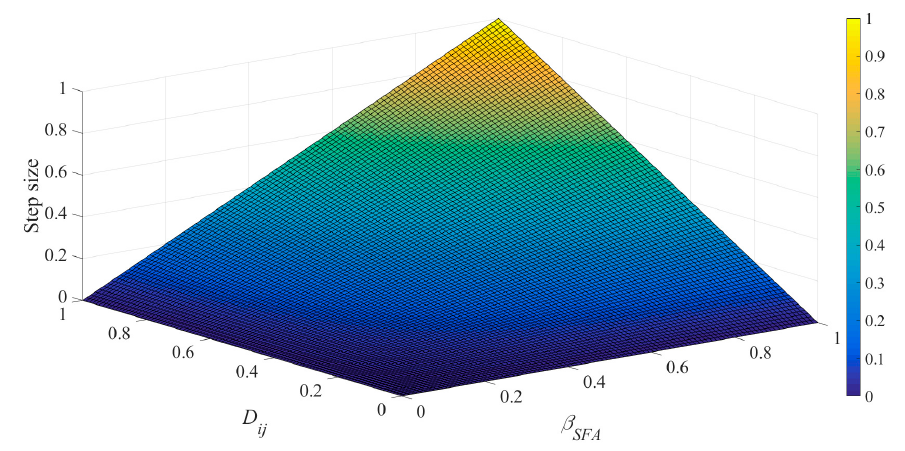
Figure 10. Relationship between the step sizes, degree of attractiveness β SFA and distance D ij in the SFA process.